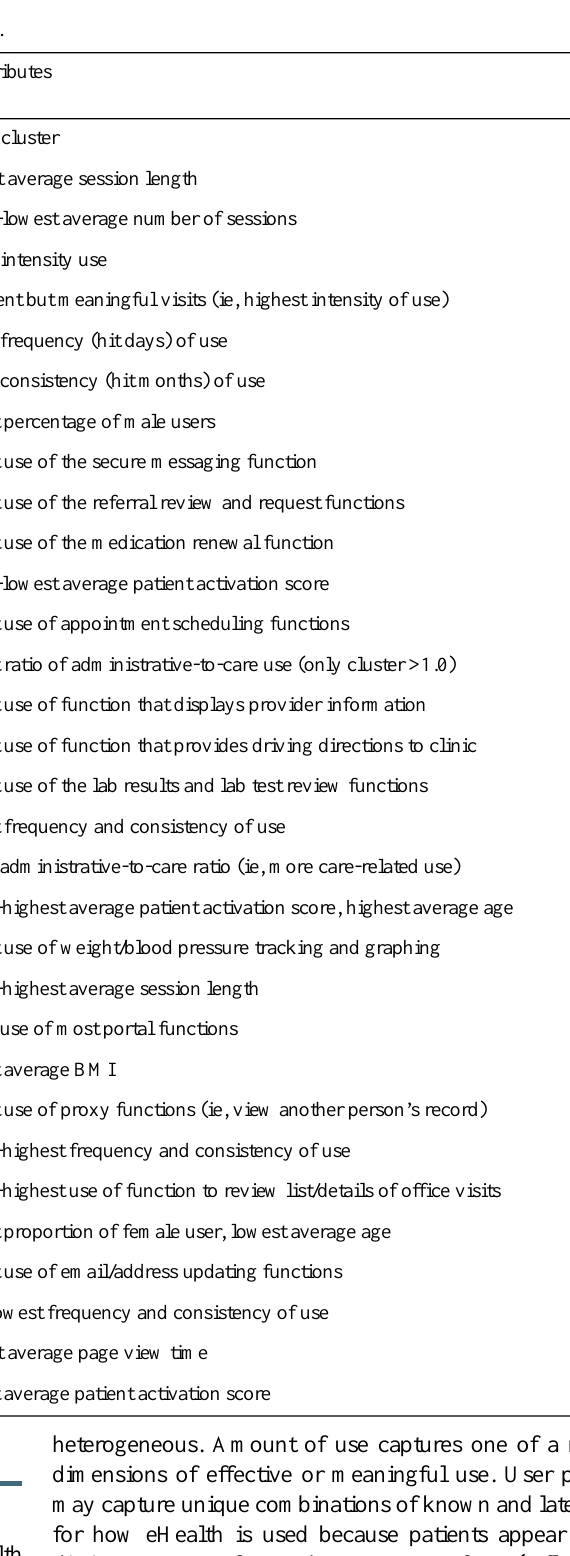
Table 5. Eight eHealth patient types based on Web portal use patterns.